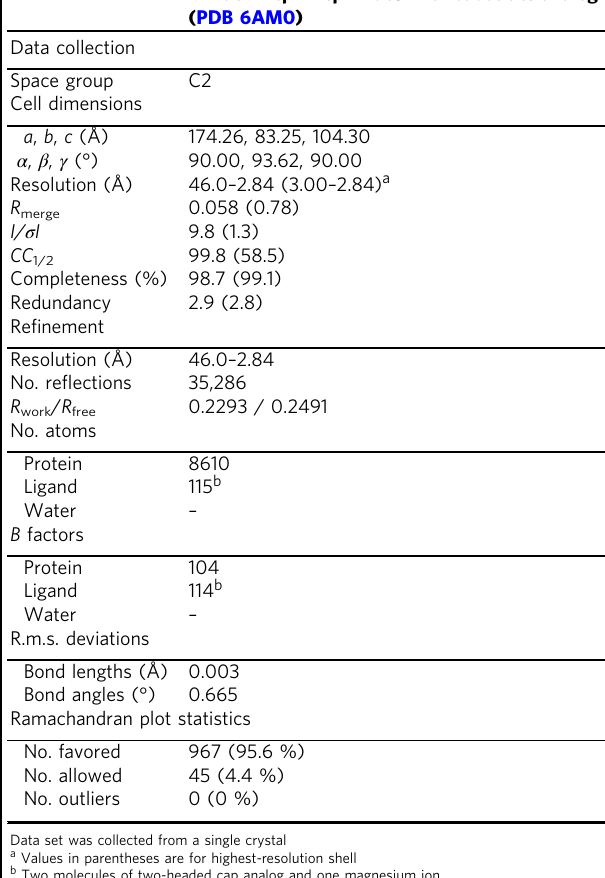
Table 1 Crystallographic data collection and re fi nement statistics Kl Edc1 – Dcp1 – Dcp2 – Edc3 with substrate analog (PDB